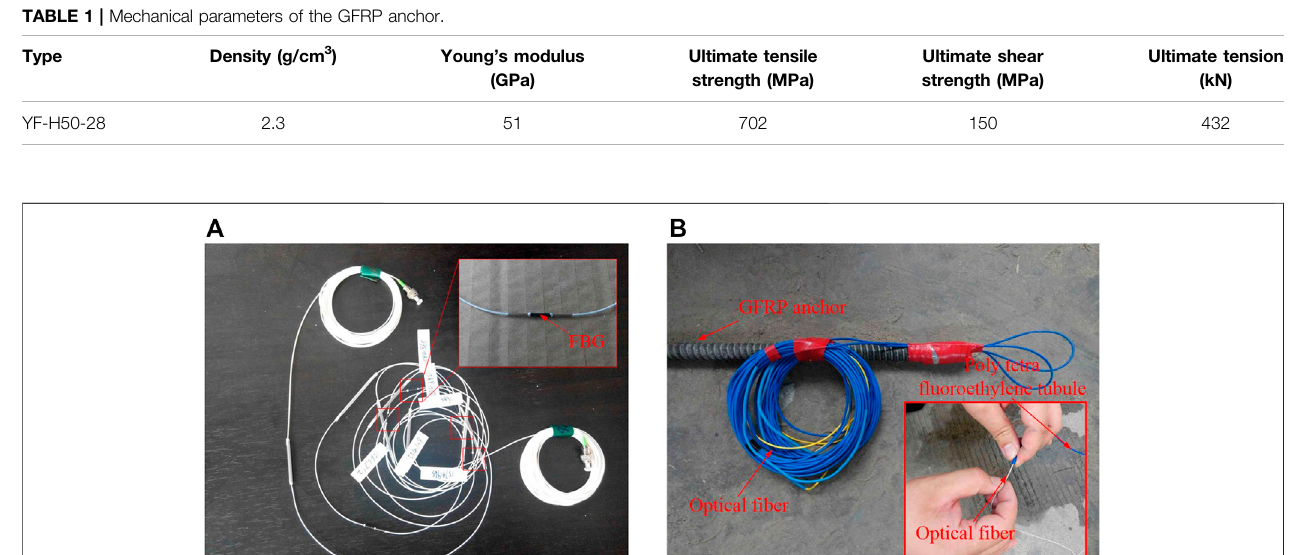
FIGURE 2 | FBG strain sensors and GFRP anchor: (A) FBG strain sensors and (B) GFRP anchor with FBG sensors.